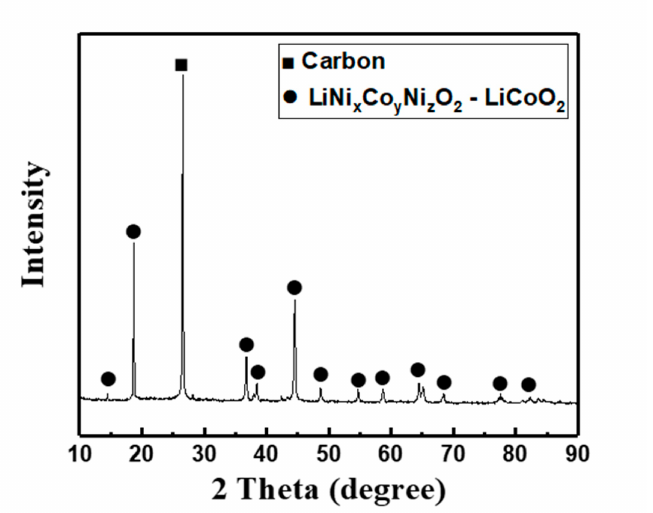
Figure 3. Spent LIB powder XRD analysis.